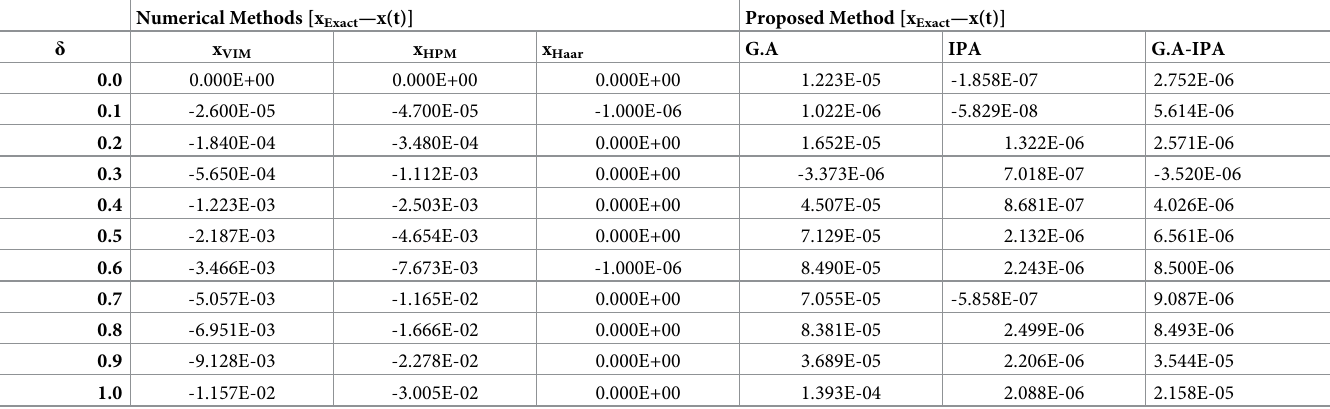
Table 11. Comparison of absolute errors for different δ and t = 0.5.